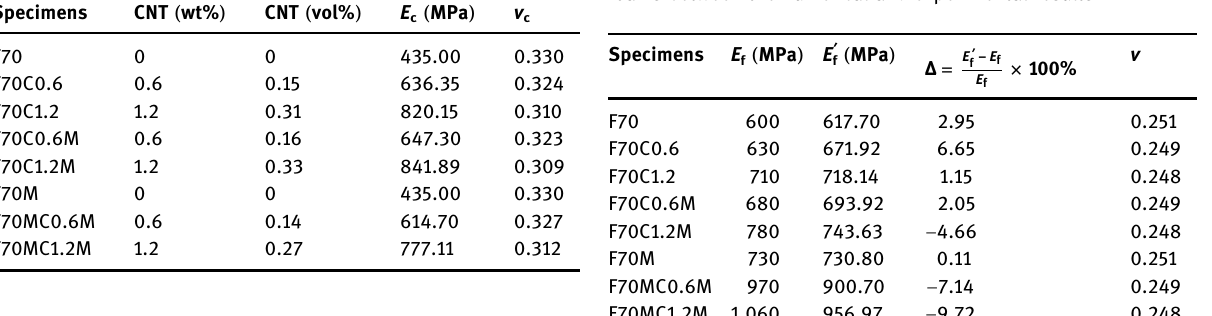
Table 7: Comparisons of the mechanical properties of syntactic foams between the numerical and experimental